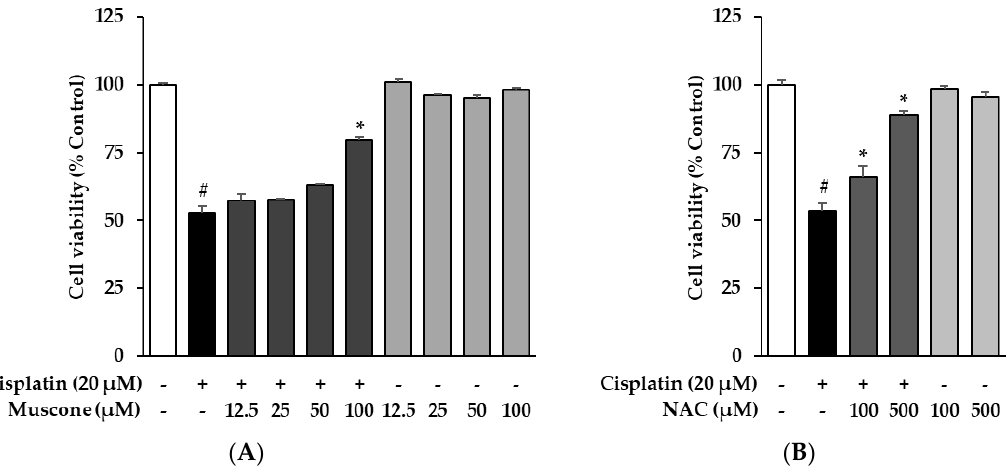
Figure 2. Protective e ff ects of muscone against cisplatin-induced cytotoxicity in kidney proximal tubule LLC-PK1 cells. ( A ) LLC-PK1 cells were treated with 20 µ M cisplatin and indicated doses of muscone for 24 h; cell survival was detected using the Ez-Cytox cell viability assay kit. ( B ) NAC was used as the reference drug. The results are described as the mean ± SD ( N = 3). Notes: # p < 0.05 compared